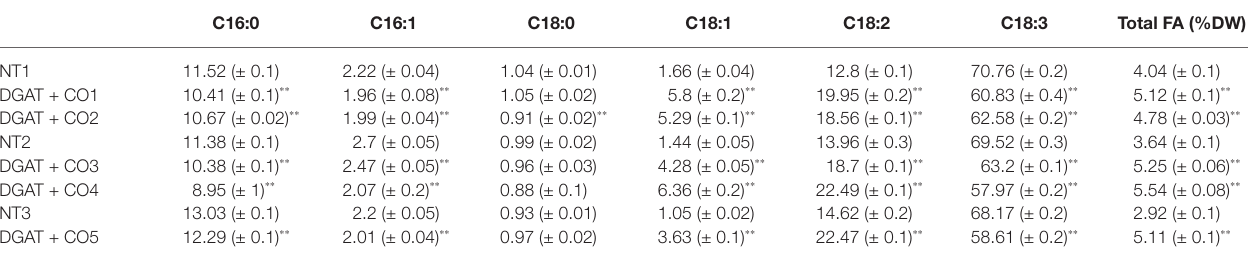
TABLE 1 | Fatty acid profile (% total FA) and total fatty acids (% Leaf DW) of five DGAT + CO lines and three non-transformed (NT) controls.